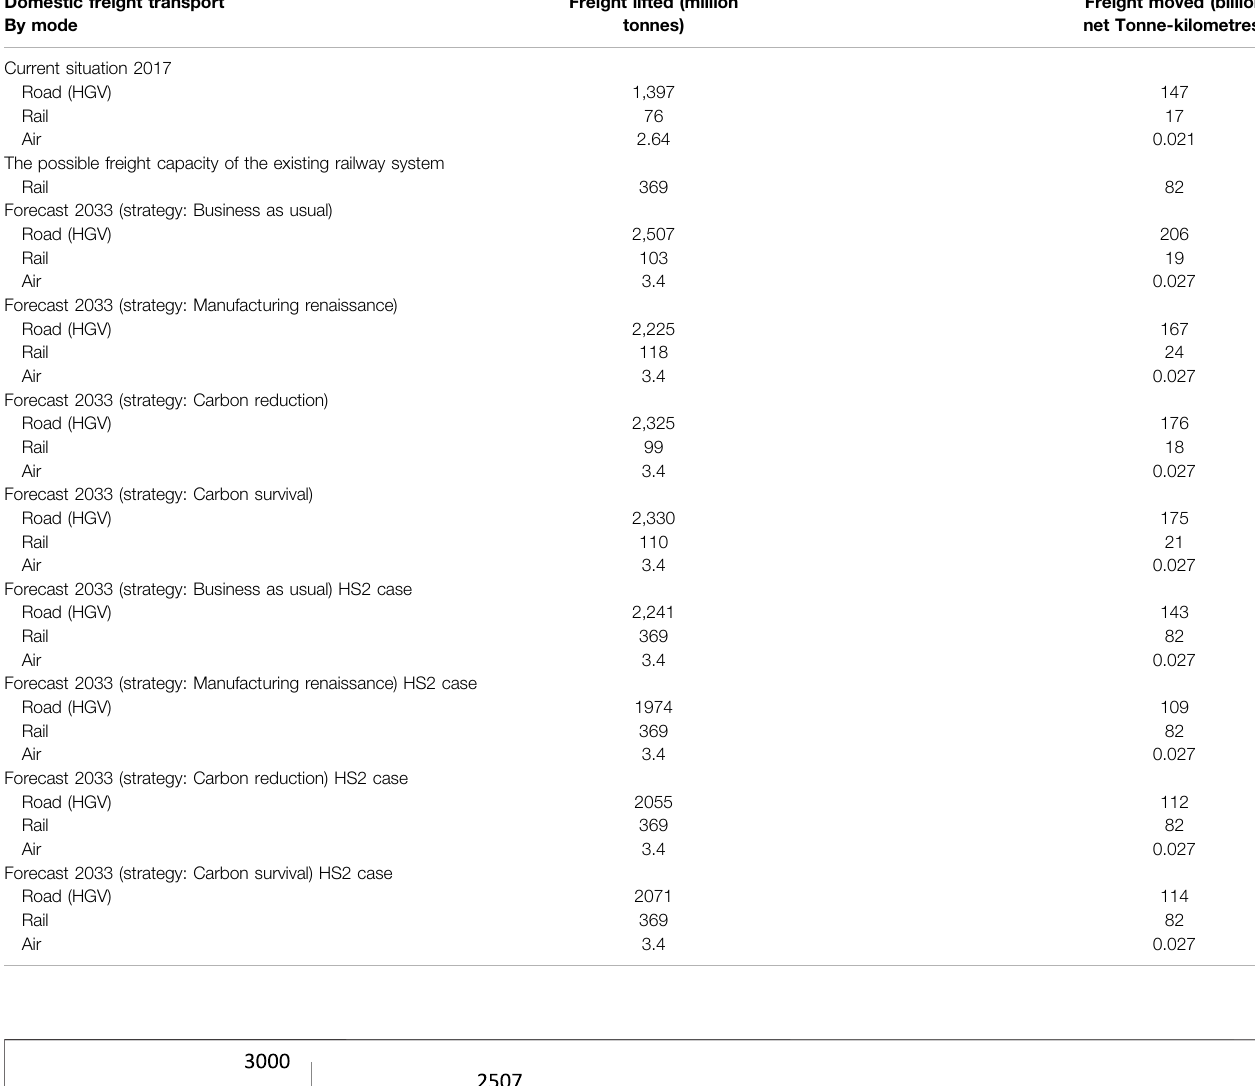
TABLE 3 | Freight lifted and moved by transport mode.